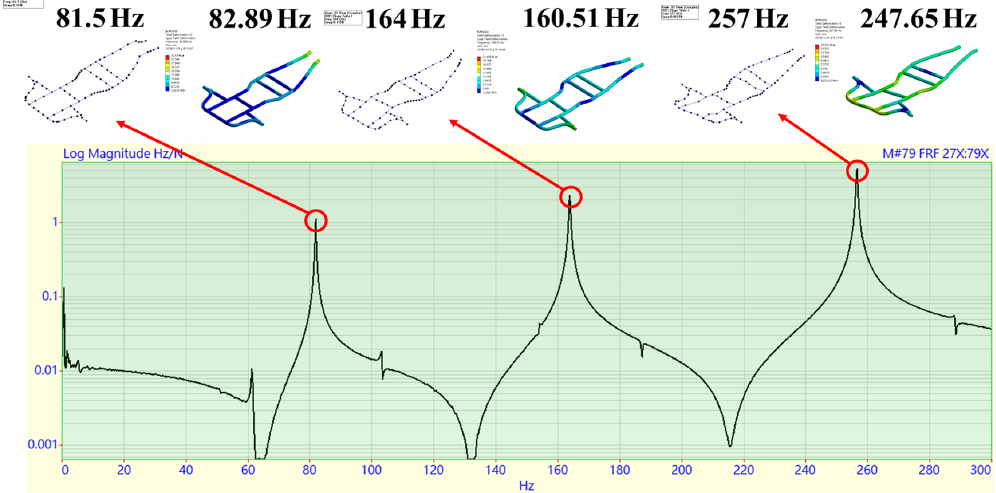
Figure 35. Frequency response function graph ( y axis).